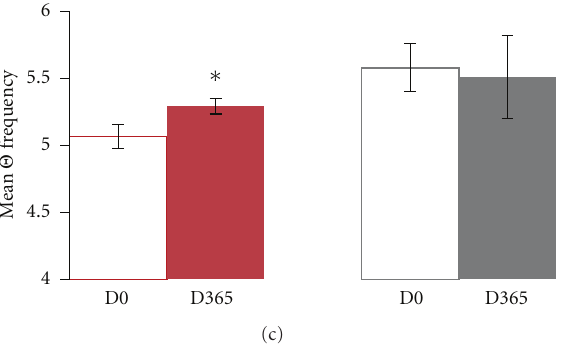
Figure 7: E ff ects of IGF1 treatment on brain activity. (a) Spectrum of frequencies (left) and EEG trace (right) for the site C4-T4 in all the treated subjects S1–S6 at D0 and D365. (b) Spectrum of frequencies (left) and EEG trace (right) for the site C4-T4 in all the untreated controls C1–C6 at D0 and D365. The color bar on the right shows intensity scale. (a) and (b): Frequencies spectrum Y -axis (blue plots) ranging between 0 and 15 Hz; X –axis ranging between 0 and 1700sec. EEG traces Y -axis (white plots) ranging between − 1.5 and +1.0mV; X -axis ranging between 0 and 1700 sec. (c) Quantification of theta frequency (site C4-T4) in all the treated (T-red) and all the nontreated (NT-grey) RTT patients at D0 (non filled) and D365 (filled). There is a significant increase in theta frequency between the treated but not the untreated patients (Wilcoxon